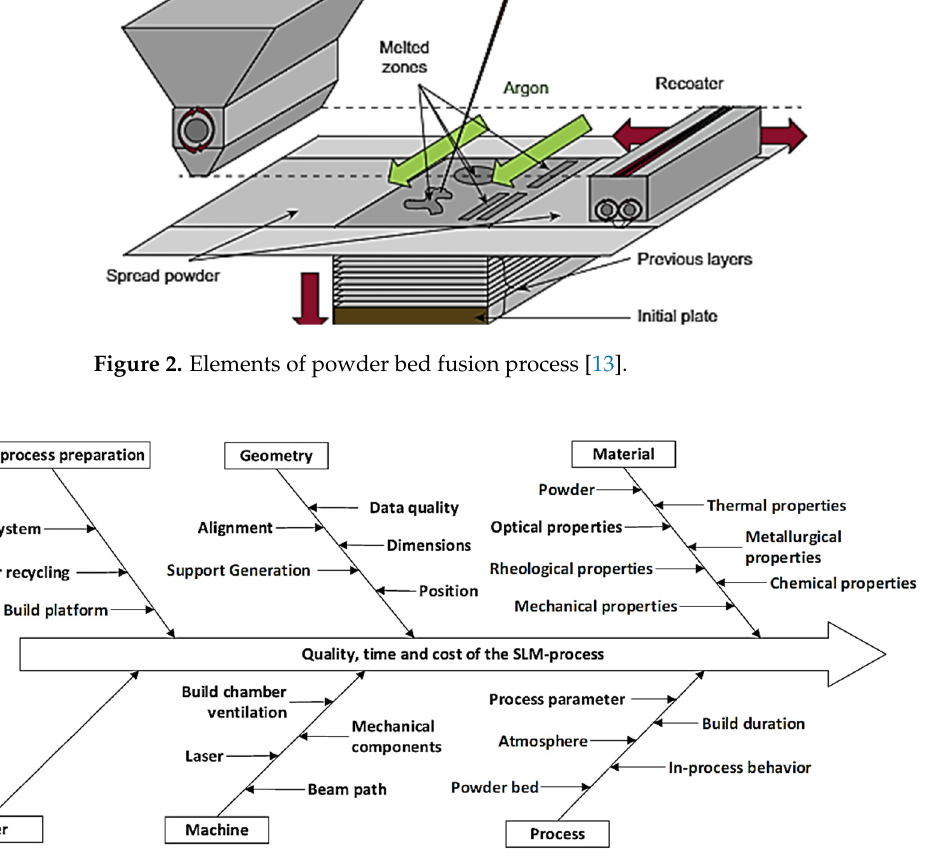
Figure 3. Ishikawa diagram of influential factors in SLM process [14].